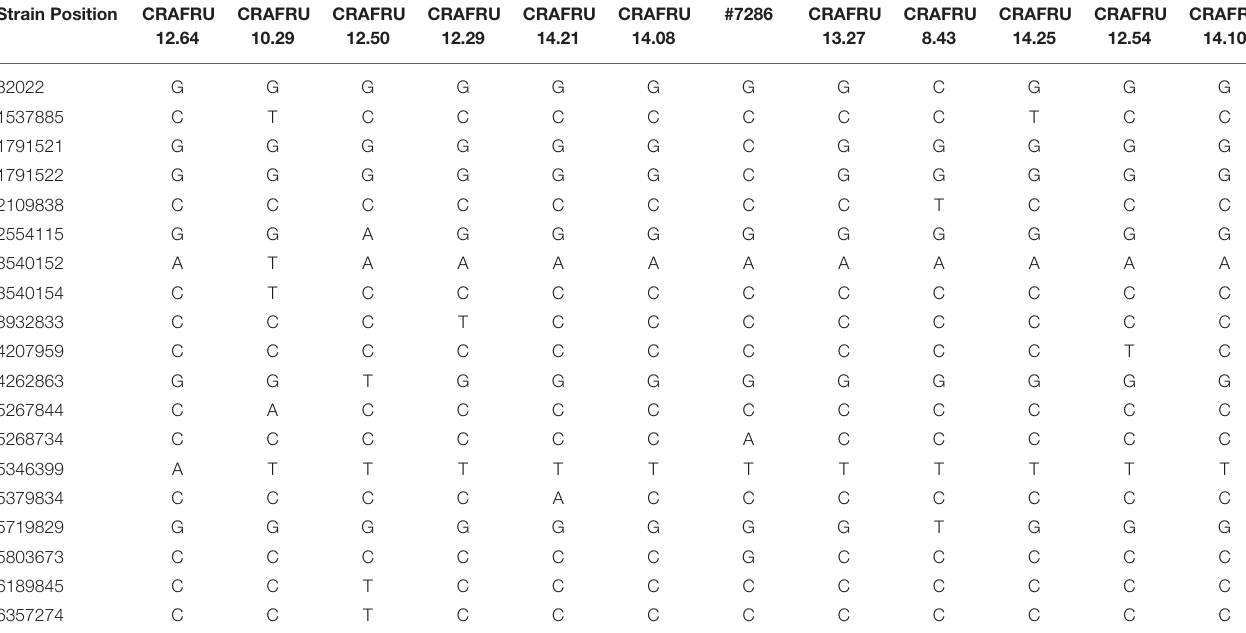
TABLE 2 | SNPs identified among the strains used in this work by Illumina reads mapping. Position relative to the chromosome of CRAFRU 14.08. Strain Position CRAFRU